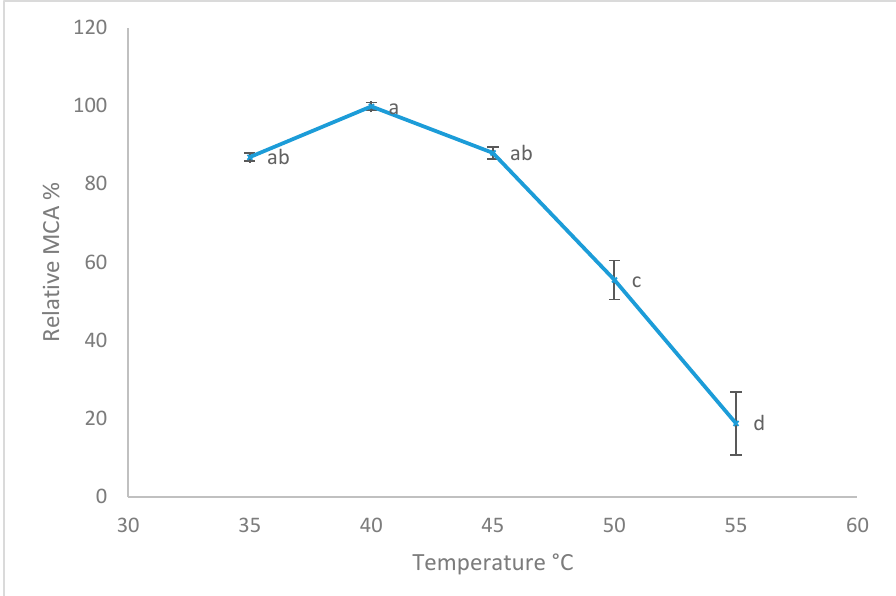
Figure 4. Temperature’s effect on MCA of aqueous extract of pulp ripe kiwifruits. The percentage (%) of relative MCA represents the mean of three independent determinations performed in triplicate. The maximum value of MCA was 100%. Error bars represent standard deviations. Different lowercase letters (a, b, c and d) indicate a significant difference among samples at p < 0.05 (ANOVA with Tukey’s post hoc test).